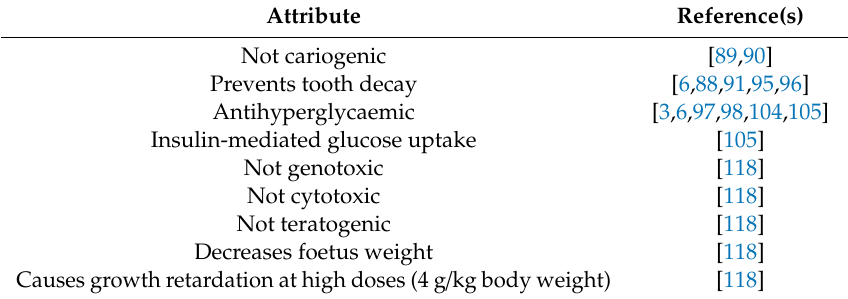
Table 5. The main attributes of maltitol for its consumption, taking into account impacts on